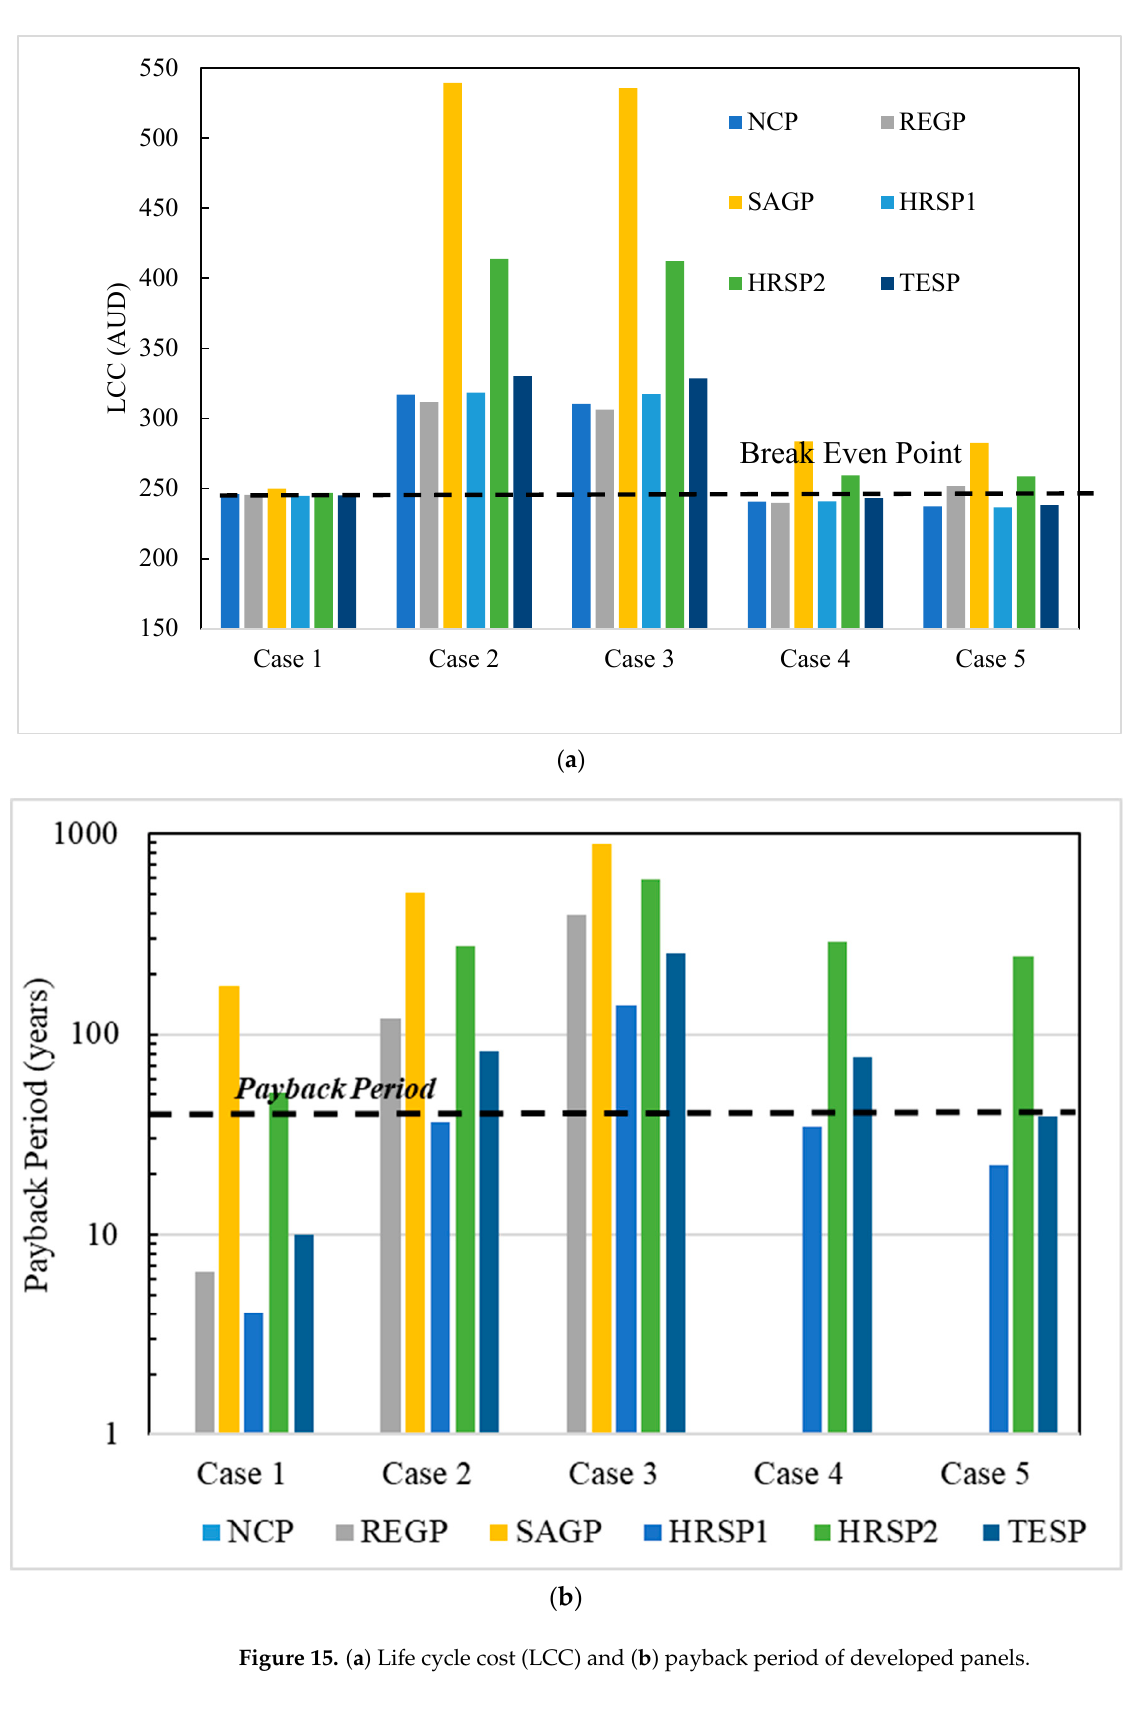
Figure 15. ( a ) Life cycle cost (LCC) and ( b ) payback period of developed panels.